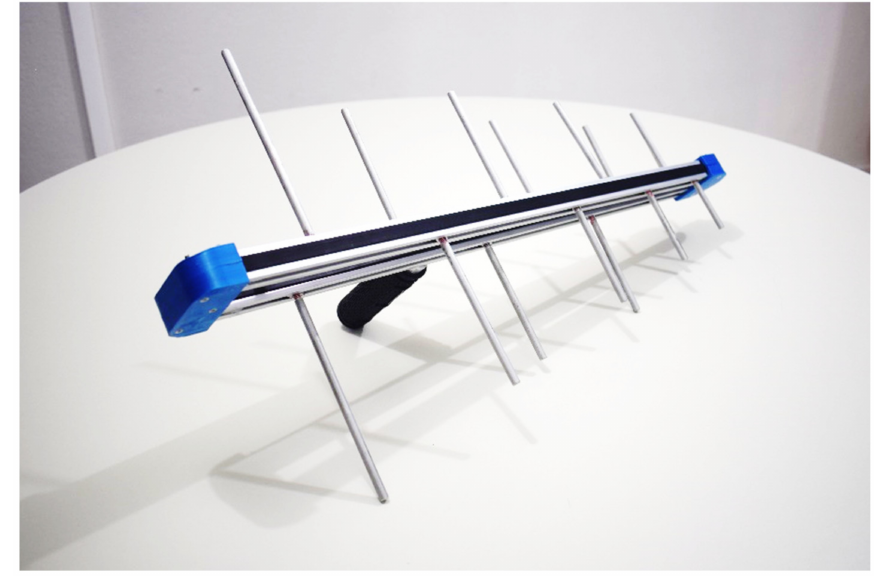
Figure 9. The antenna designed for this